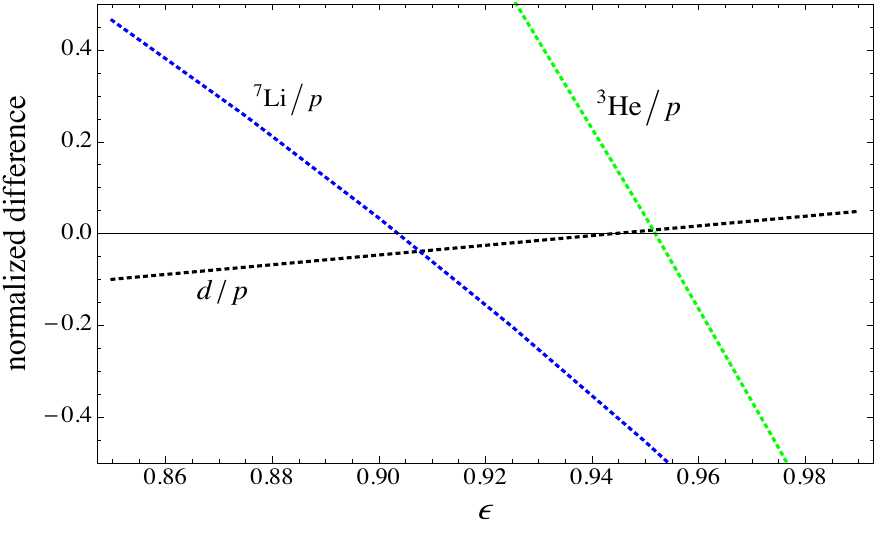
Figure 7. The normalized differences between the model and the observed nuclide ratios for d/p in dotted black, the 3 He /p in dotted green and 7 Li /p in dotted blue as a function of the branching ratio (cid:15)